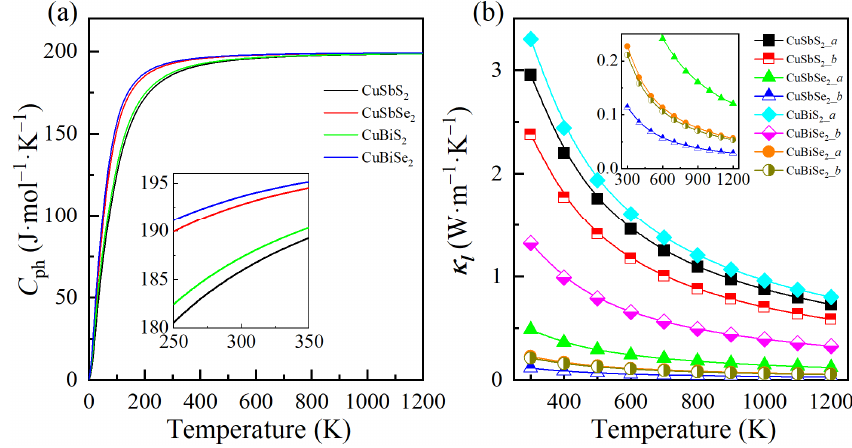
Figure 8. ( a ) The volumetric specific heat, and ( b ) lattice thermal conductivity of 2D CuMN 2 (M = Sb, Bi; N = S, Se).